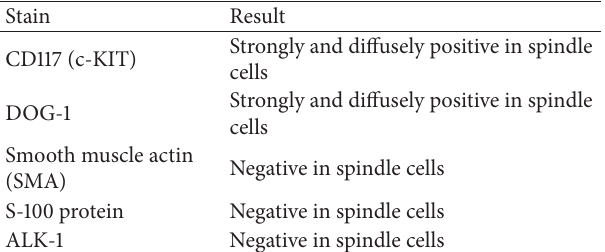
Table 1: Immunohistochemical stains performed on our pancreatic GIST